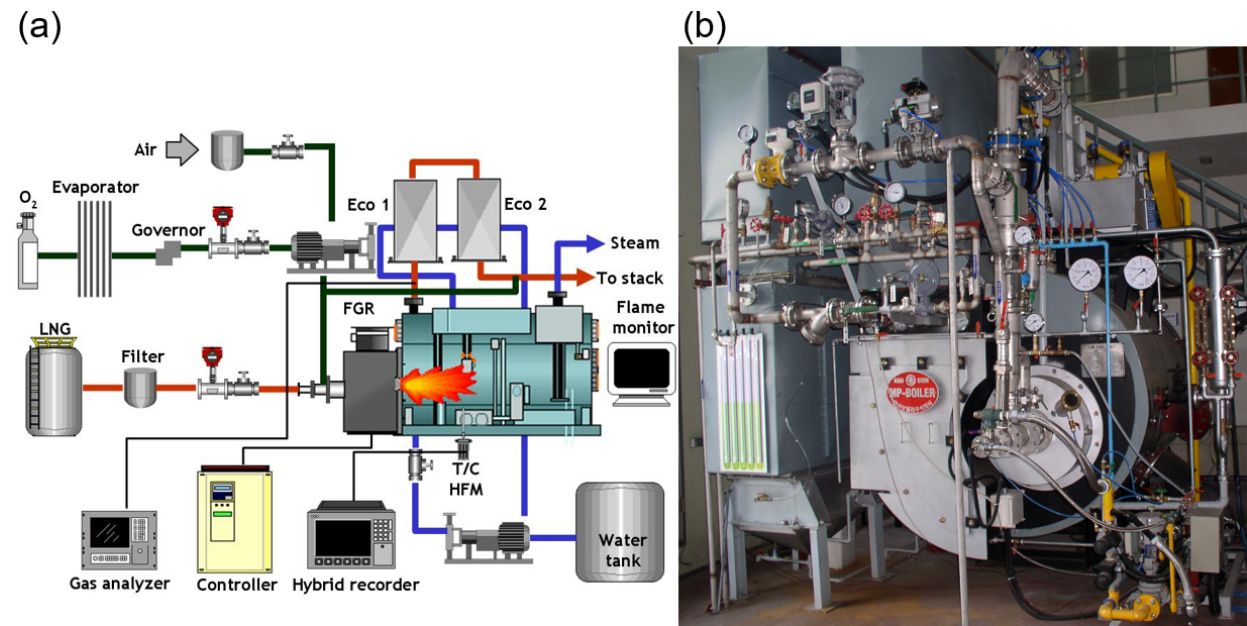
Figure 3. Experimental setup: ( a ) a schematic and ( b ) a photograph.